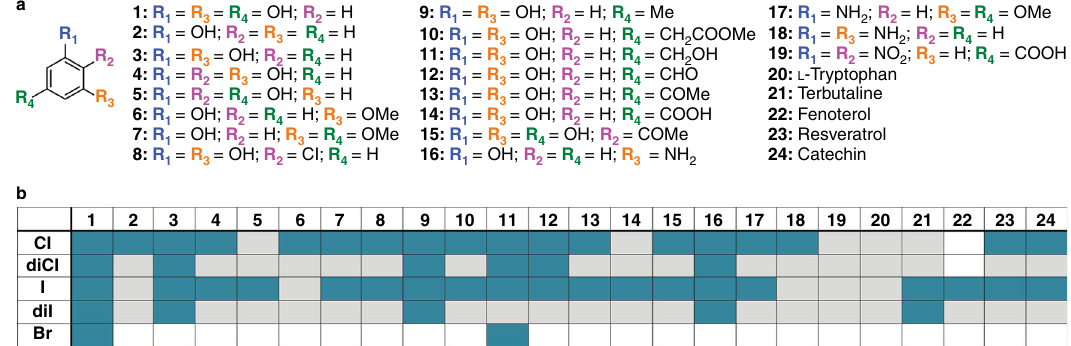
Fig. 3 Substrate pro fi le of PltM by LC-MS. a Compounds tested as potential substrates of PltM. b Summary of halogenation assay results. The top row and left column indicate the tested substrate and expected halogenation, respectively. Observed and unobserved halogenation are indicated by blue and gray boxes, respectively, while white boxes indicate untested